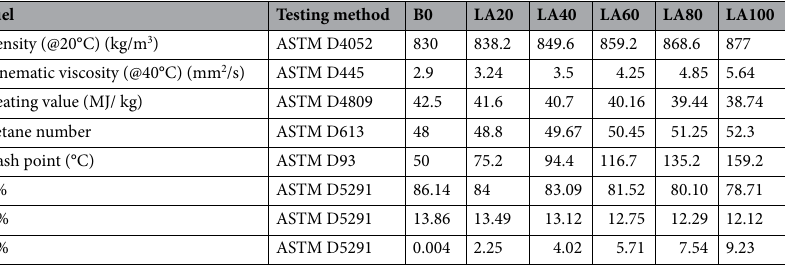
Table 3. Important physical–chemical properties of diesel, Roselle and its